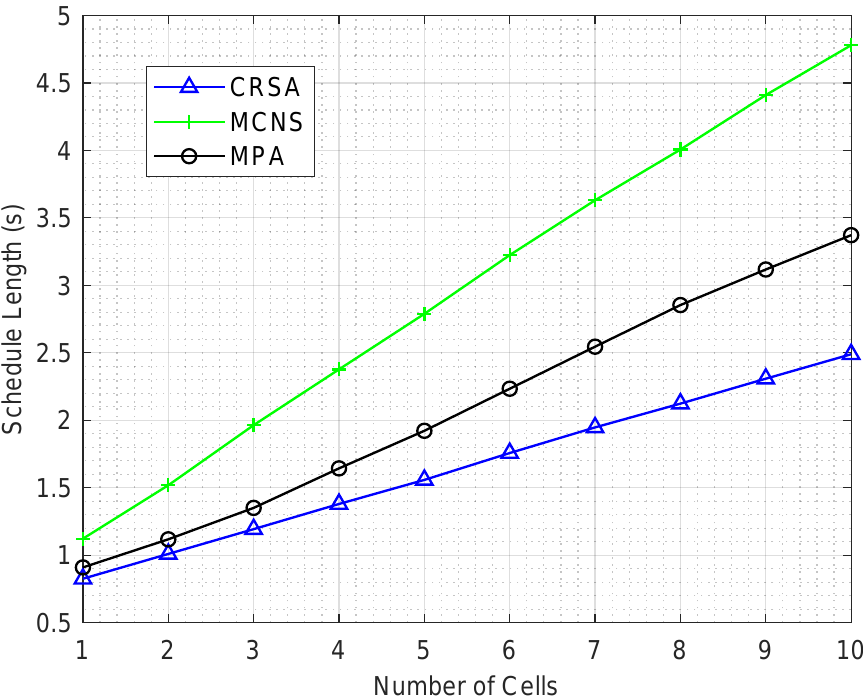
Figure 3. Schedule length of the algorithms for different number of HAPs with five users in each HAP.